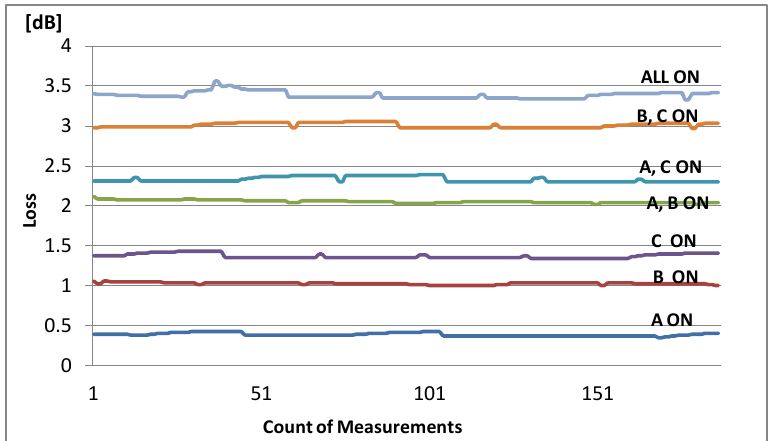
Figure 6. Experiment results for bending